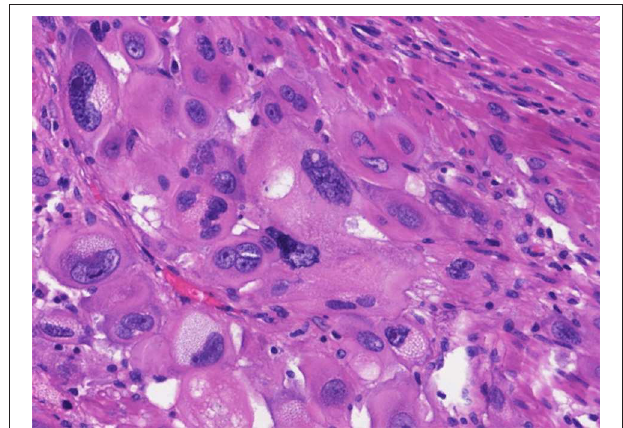
FIGURE 3 | Histopathological features of PSTT. Tumor cells present monomorphic population of large polyhedral cells with irregular hyperchromatic nuclei, which are at different stages of mitosis. Besides, there is eosinophilic or transparent substance in the cytoplasm that could be large amount of fibrin. Tumor cells grow like nest or bands into myometrium, with a handful of bleeding foci and mild inflammation or necrosis.